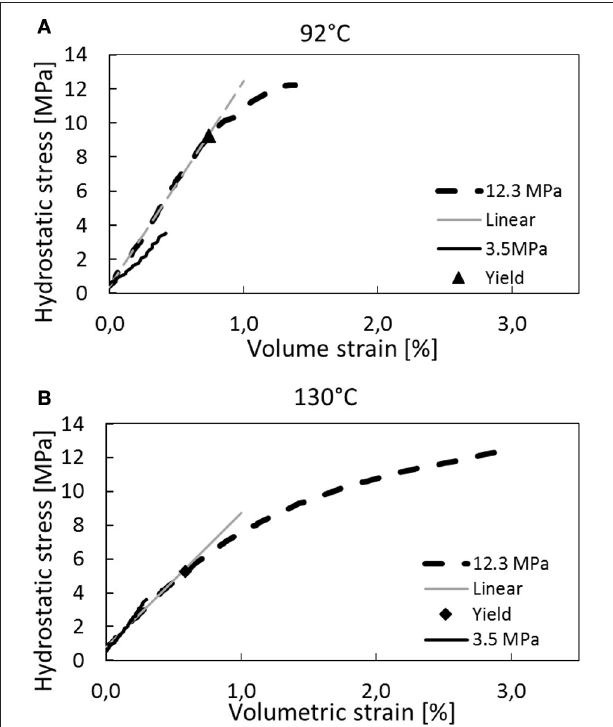
FIGURE 2 | Stress–strain curves during loading to hydrostatic confining pressures of 4.2 and 13.0 MPa (i.e., 3.5 and 12.3 effective stress). In (A) the 130 ◦ C tests are shown while the 92 ◦ C tests are displayed in (B) . The bulk modulus and onset of yield are shown in Table 4 .